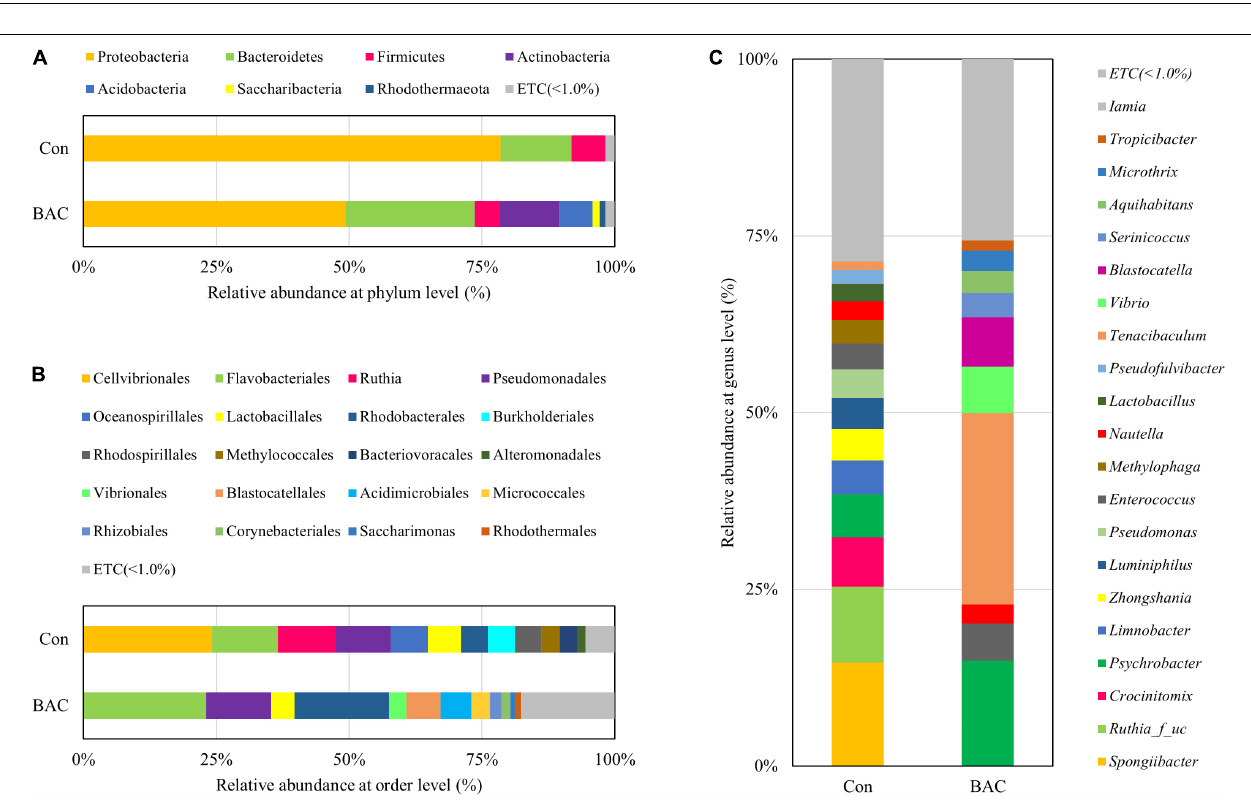
FIGURE 1 | Principal coordinate analysis based on the weighted unifrac metrics of bacterial operational taxonomic units between the different diets.